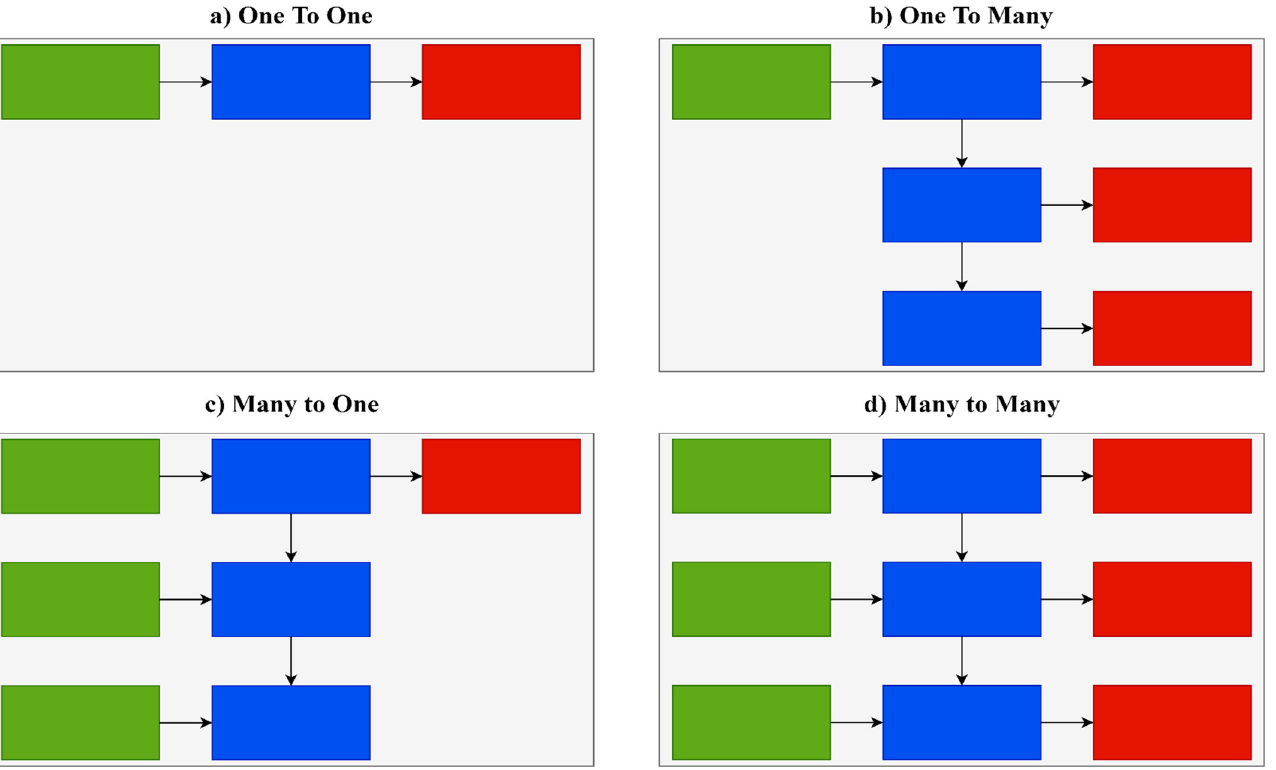
Figure 4. RNN types. ( a )—one to one, ( b )—one to many, ( c )—many to one, ( d )—many to